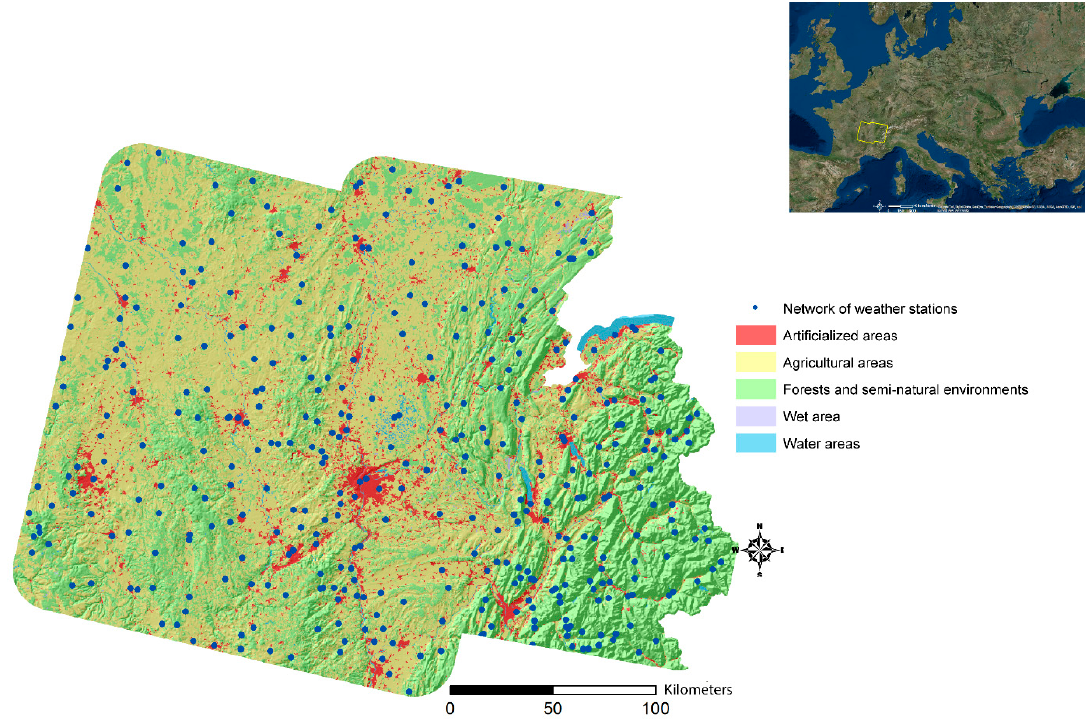
Figure 1. M é teo-France network used and land use on the right-of-way of Landsat 196-28 and 197-28 tiles (data: M é t é o-France [30] and Corine Land Cover, 2012 [31]). Table 2. Meteorological parameters of study days at the Lyon-Bron station at 12:00 p.m. (data: M é t é o-France